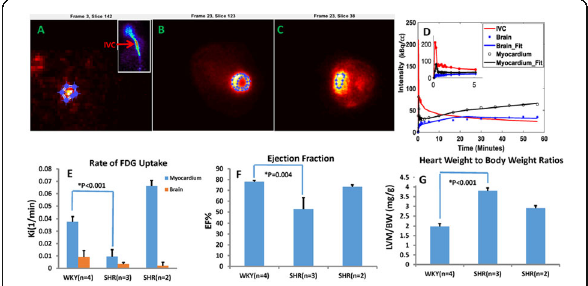
Fig. 1 (abstract A7). Total Body Dynamic FDG PET imaging. Regions of interest (ROI) shown on representative (A) Inferior vena cava (IVC) at early time point (inset: sagittal view), (B) Myocardium and (C) Brain transverse images at late time point from dynamic FDG PET images in vivo , (D) Time activity curves (TAC) shown for the blood (IVC) corrected by recovery coefficient, myocardium and the brain and